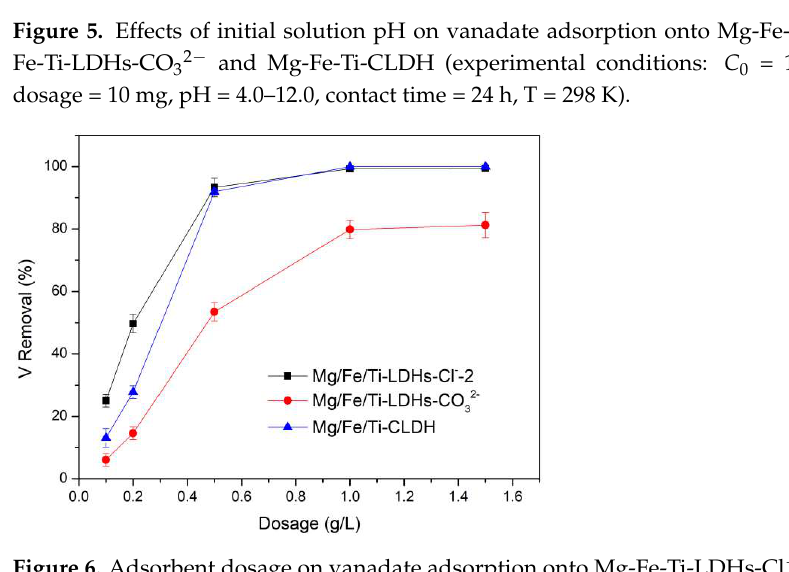
Figure 5. Effects of initial solution pH on vanadate adsorption onto Mg − Fe − Ti − LDHs − Cl − − 2, Mg − Fe − Ti − LDHs − CO 32− and Mg − Fe − Ti − CLDH (experimental conditions: C 0 = 10 mg/L, adsor- bent dosage = 10mg, pH = 4.0–12.0, contact time = 24 h, T = 298 K).